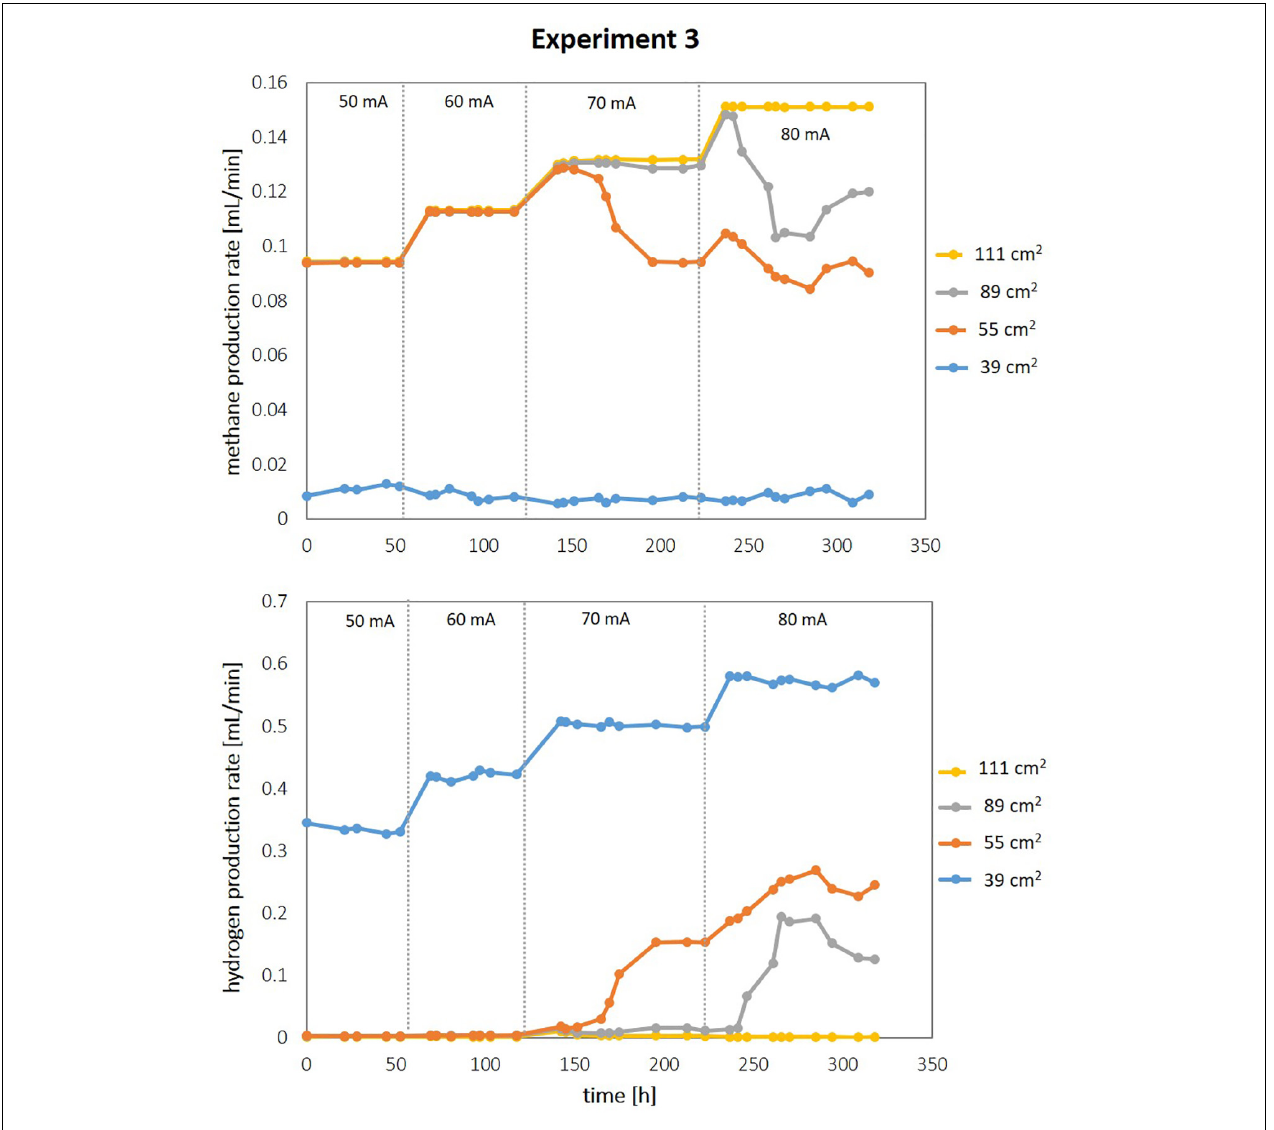
FIGURE 4 | Effect of increasing current density on electromethanogenesis performance in reactors with different cathodic surface areas. Methane production rate and unused hydrogen in the reactor off gas during Exp3. The total supplied current was increased stepwise as indicated per dashed vertical lines. Initial OD =